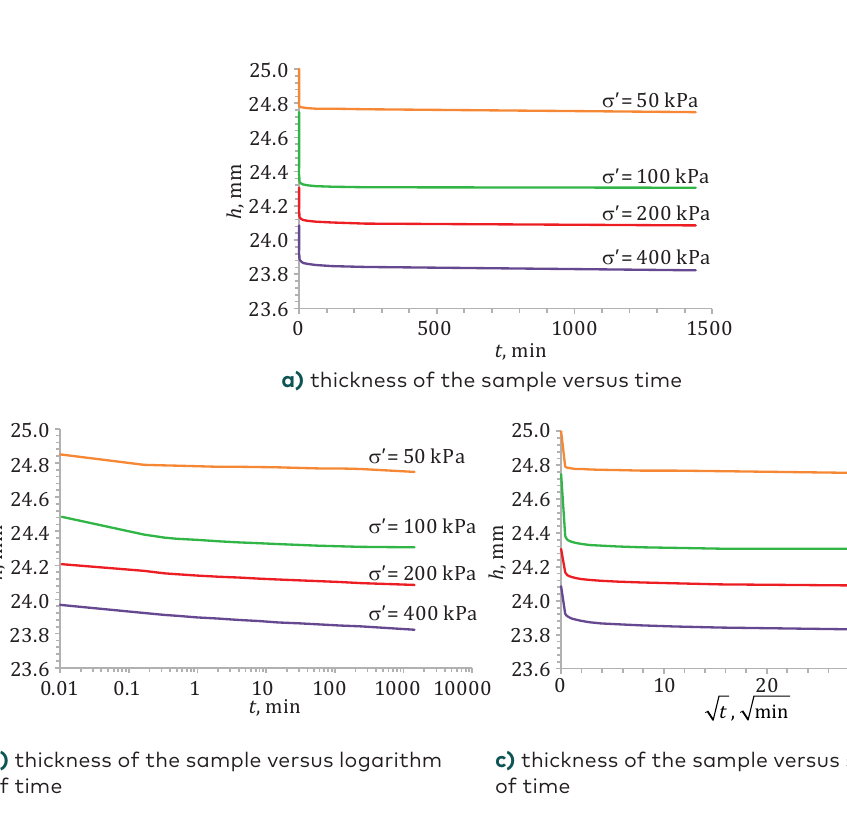
Figure 8. Consolidation test results of FA+5%B